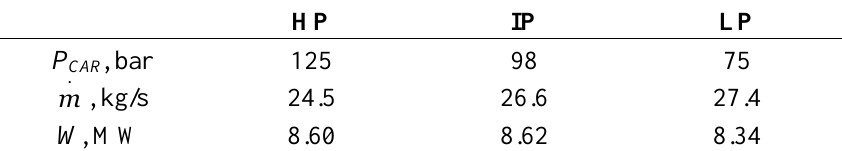
Table 1. Turbo-expander train reference operating conditions.